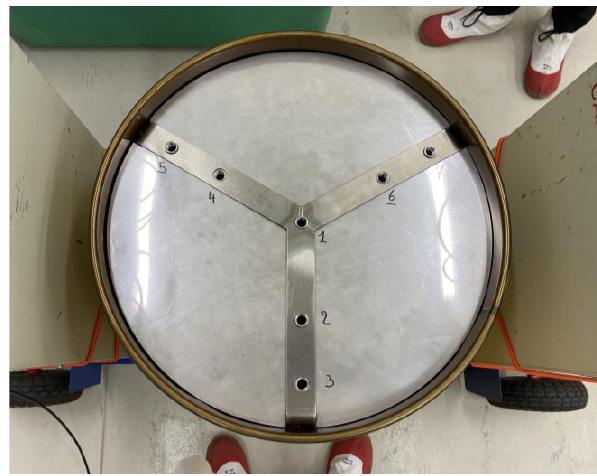
Figure 3: Top view from an ESARDA drum showing the locations of the vertical channels for the positioning of radioactive sources.